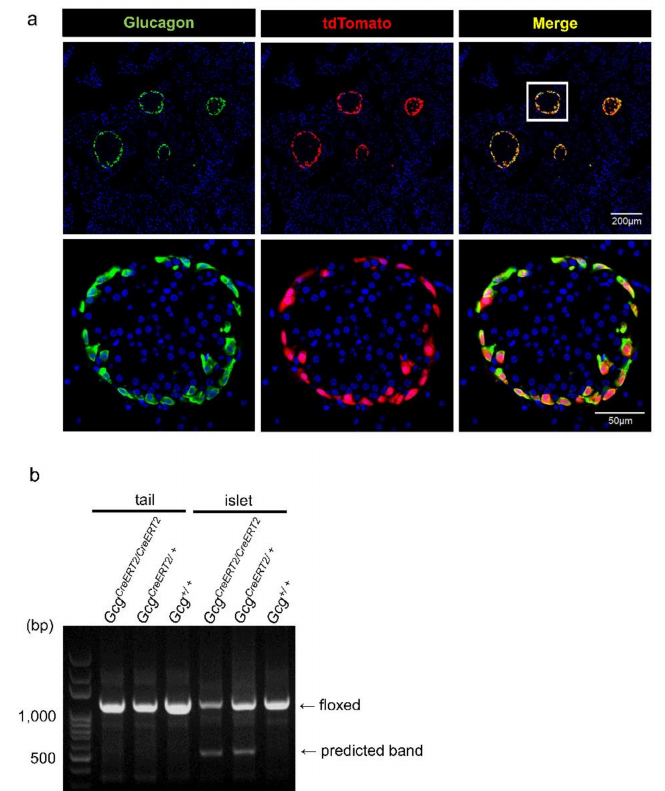
Figure 3. Establishment of α -cell-specific Pkc δ -knockout mice. ( a ) Pancreatic sections of Gcg CreERT2 ; Rosa26 tdTomato mice were subjected to immunohistochemistry with rat monoclonal anti-glucagon antibody. Native fluorescence of tdTomato is shown in red, glucagon is shown in green, and DAPI is shown in blue. Merge (yellow) indicates the colocalization of tdTomato with glucagon. Glucagon- positive and tdTomato-positive cells were mostly merged in Gcg CreERT2 ; Rosa26 tdTomato mice. n = 4, each group. Scale bars represent 200 µ m (upper panels) and 50 µ m (lower panels). These studies were performed under blinded analysis. ( b ) Genomic DNA was extracted from the tails and the pancreatic islets of Gcg CreERT2/CreERT2 ; Prkcd floxed/floxed , Gcg CreERT2/+ ; Prkcd floxed/floxed , and Gcg +/+ ; Prkcd floxed/floxed mice. Because the region between loxP sites is excised in the tissues where Cre recombinase is expressed, the smaller PCR products (predicted bands) were detected in the islets but not in the tails of Gcg CreERT2/CreERT2 ; Prkcd floxed/floxed ; and Gcg CreERT2/+ ; Prkcd floxed/floxed mice. This result indicated that Pkc δ was deleted in the islets of α Pkc δ KO